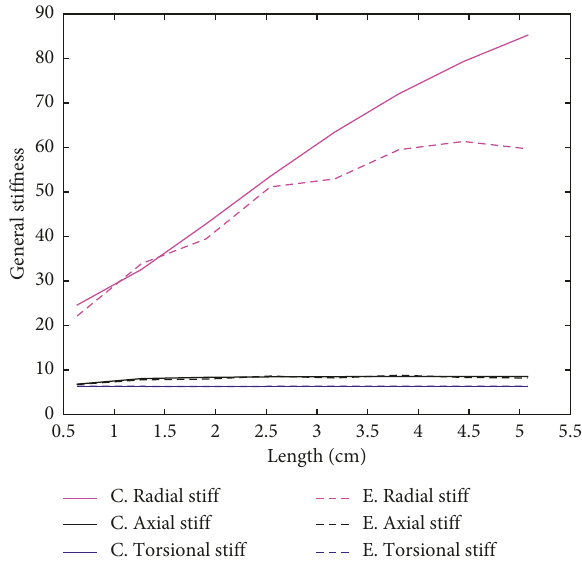
Figure 6: A general overview of the accuracy of the calculated theoretical values (C.) versus experimental data